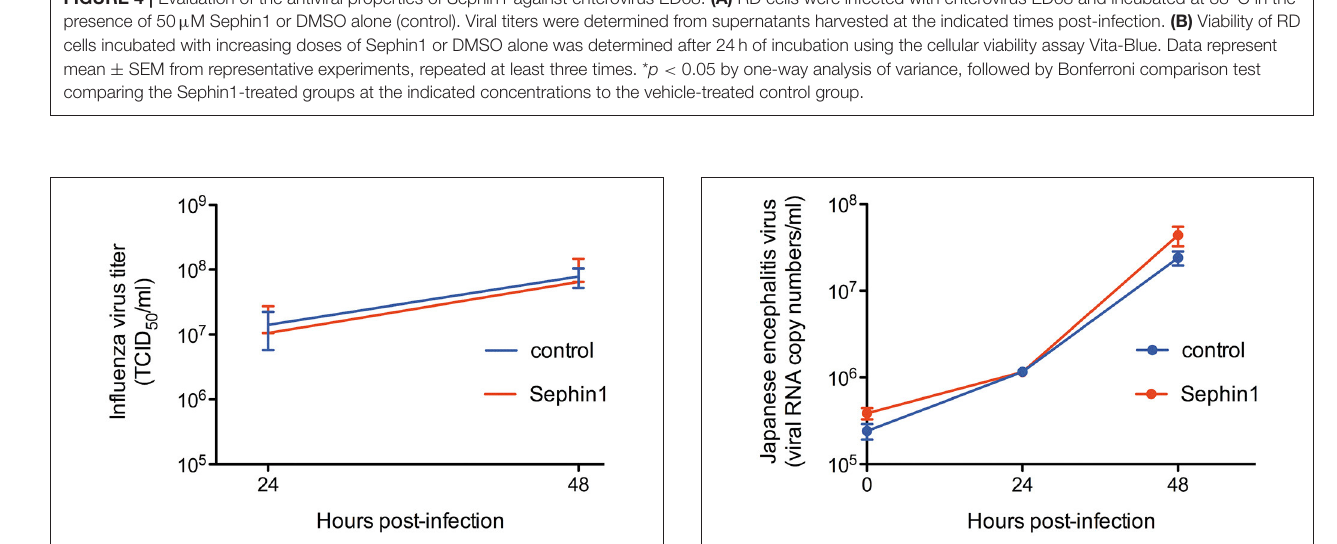
FIGURE 5 | Evaluation of the antiviral properties of Sephin1 against influenza virus. A549 cells were infected with influenza A/Puerto Rico/8/1934 (H1N1) strain and incubated in the presence of 50 µ M Sephin1 or DMSO alone (control). Viral titers were determined from supernatants harvested at the indicated times post-infection. Data represent mean ± SEM from a representative experiment, repeated at least three times.